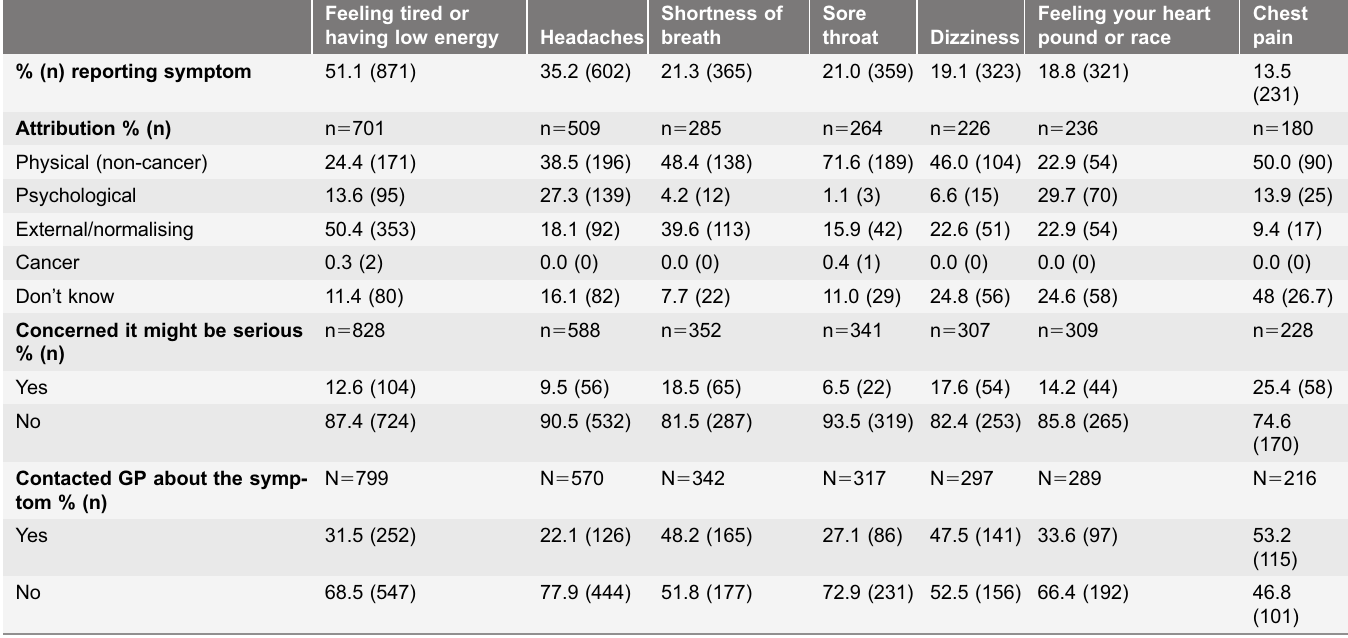
Table 4. Experience of non-alarm symptoms, symptom attributions, perceived symptom seriousness and GP